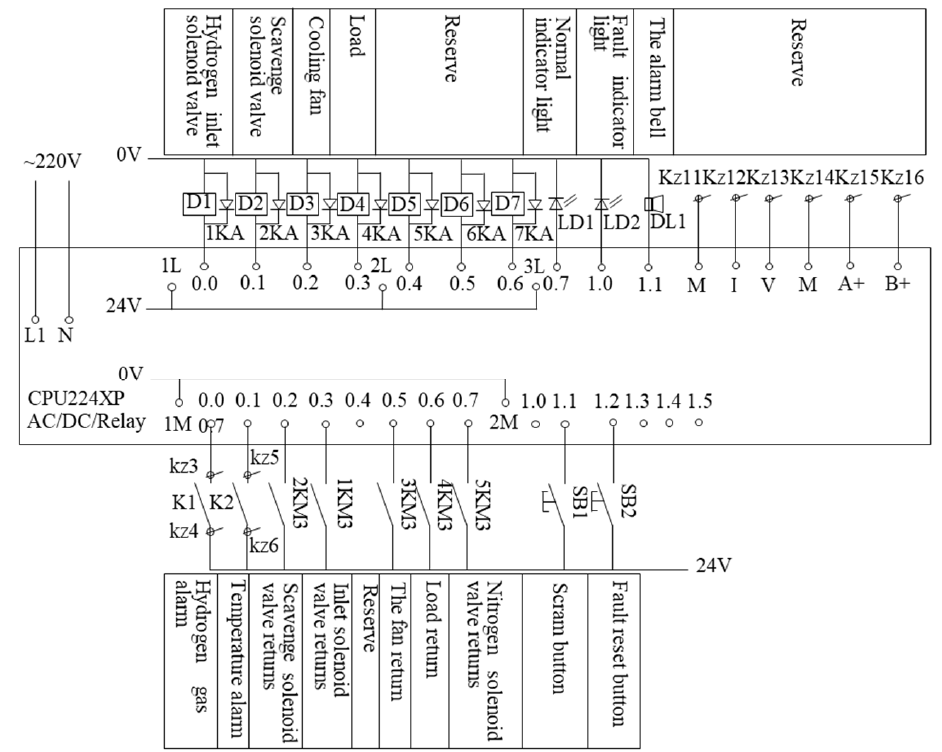
Figure 7. Main electrical connection diagram of the PLC.